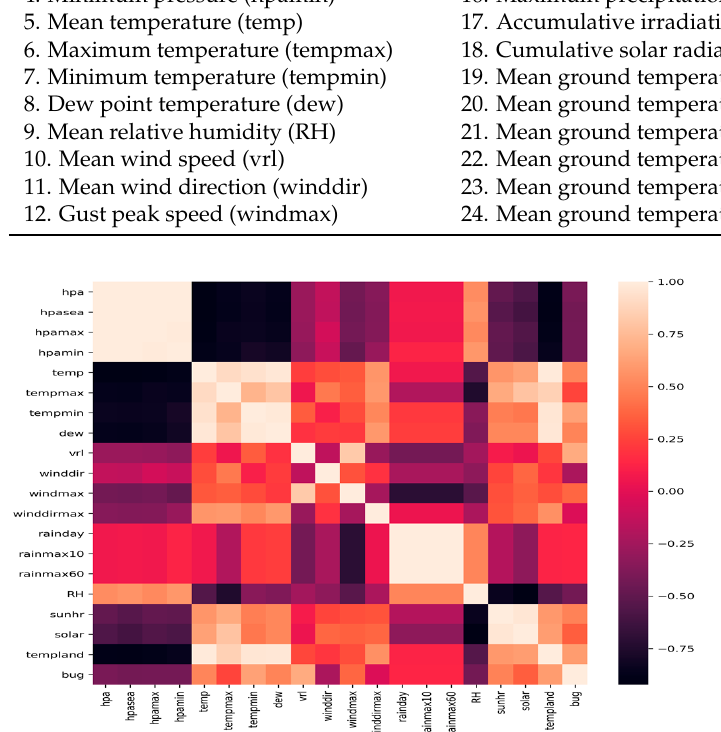
Figure 4. Correlation between climate characteristics and pest activity.